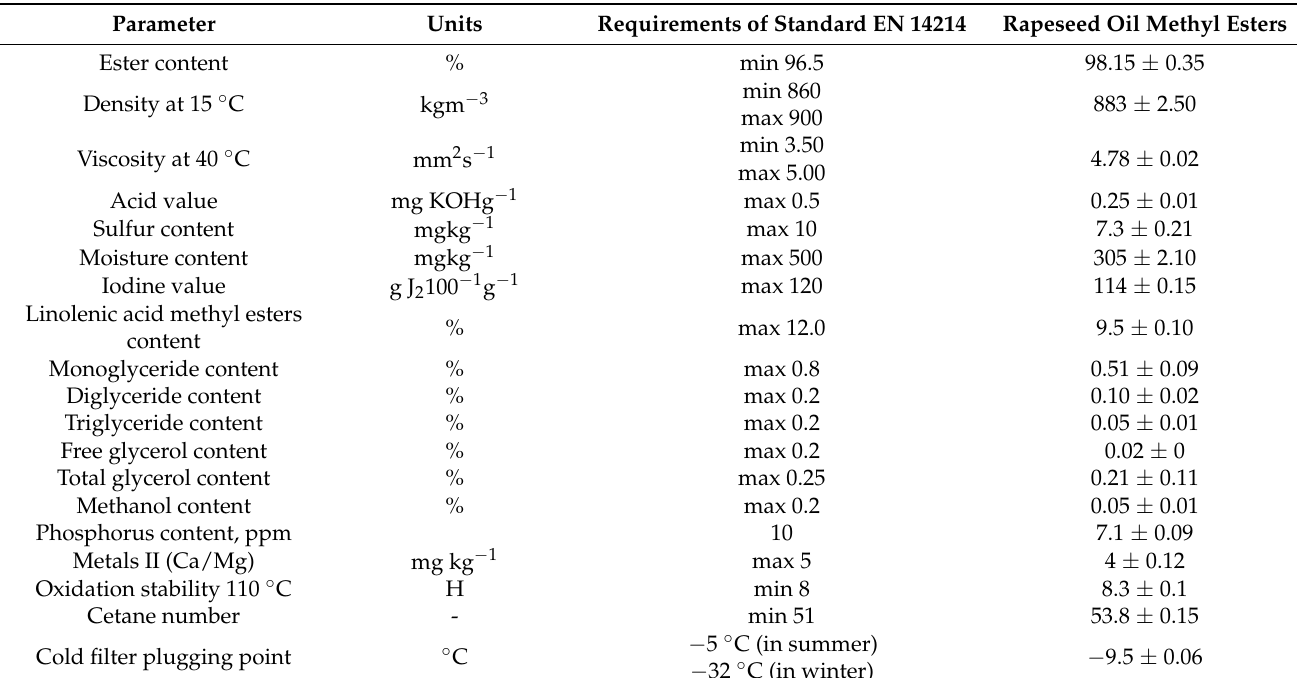
Table 6. The physical and chemical properties of rapeseed oil methyl